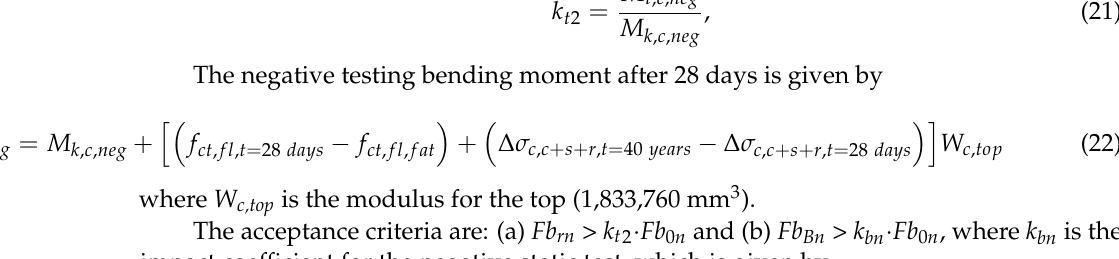
Figure 10. Static test procedure for design approval test for the negative bending moments. The factor k t 2 is given